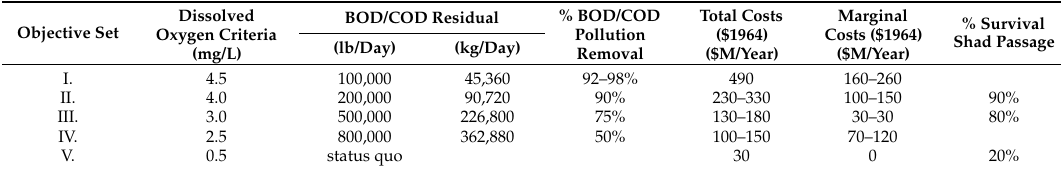
Figure 2. Delaware River Basin Commission (DRBC) dissolved oxygen criteria along the Delaware Estuary in 1968 [22]. Estuary in 1968 [22]. Table 2. Costs to meet water quality objectives in the Delaware Estuary [28]. Table 2. Costs to meet water quality objectives in the Delaware Estuary